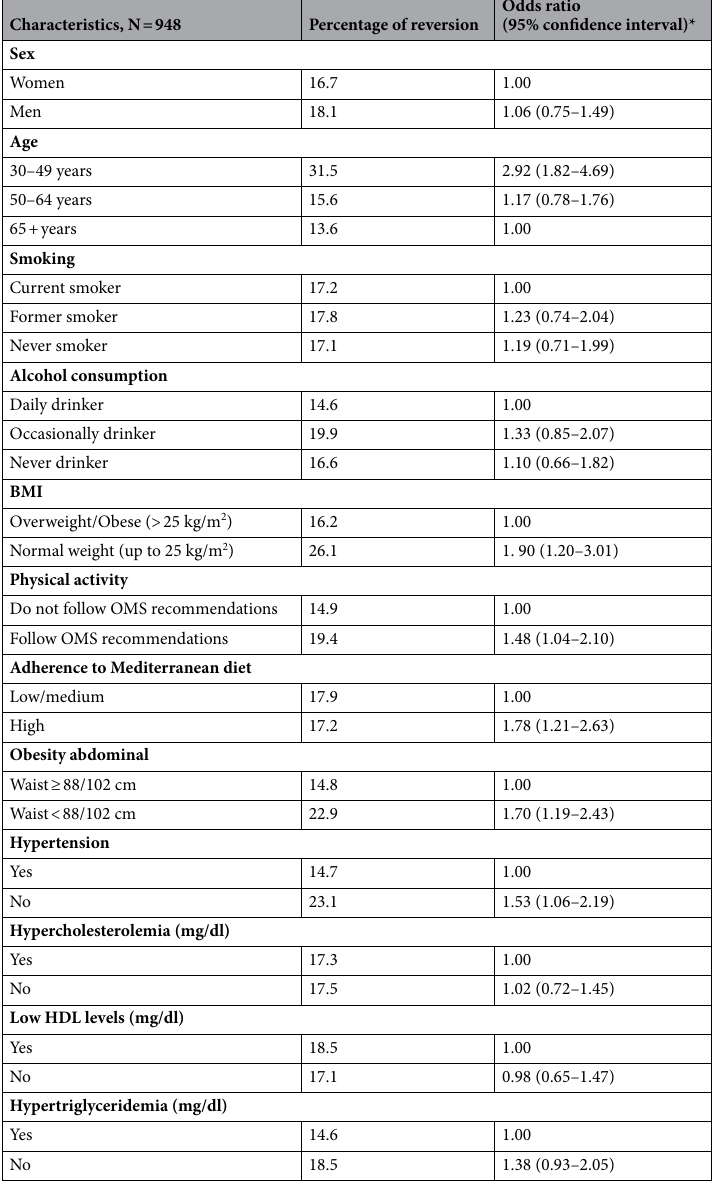
Table 2. Percentage of reversion to normal glucose regulation and odds ratio (OR) according to the characteristics of the subjects. *Sex and age adjusted odds ratio, except the odds ratios according sex and age. All variables were considered and treated as categorical